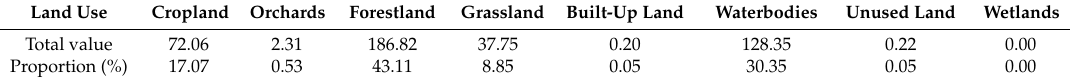
Table 4. The total and proportion of ESV of different land use types in the region (unit: 10 8 yuan).